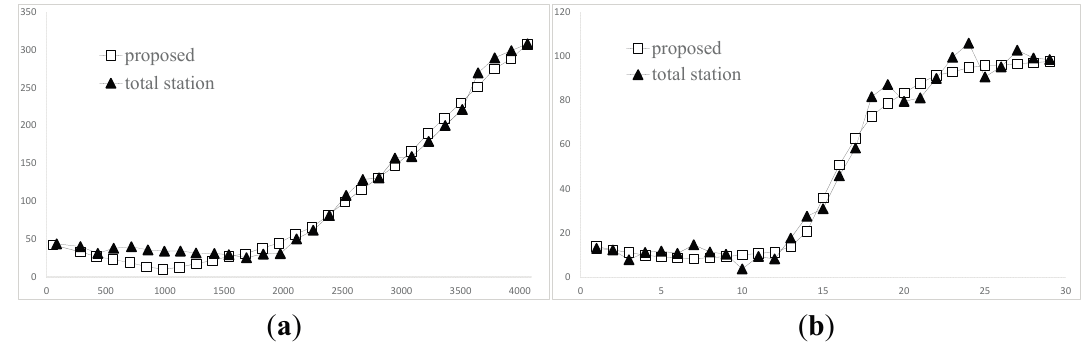
Figure 9. The results of 3D reconstruction. ( a ) XOY plane; ( b ) Elevation over the time.